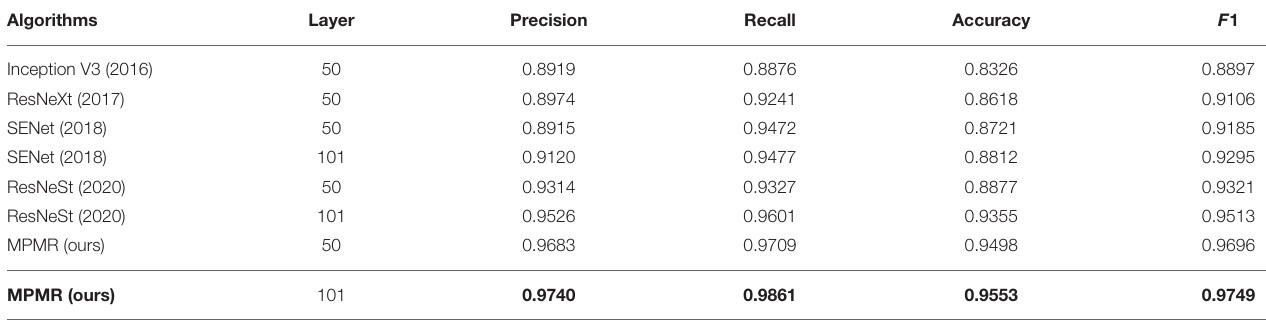
TABLE 1 | The experimental results of the proposed algorithms and comparison algorithms, the higher the values of precision, recall, accuracy, and F 1, the better the recognition performance. Algorithms Layer Precision Recall